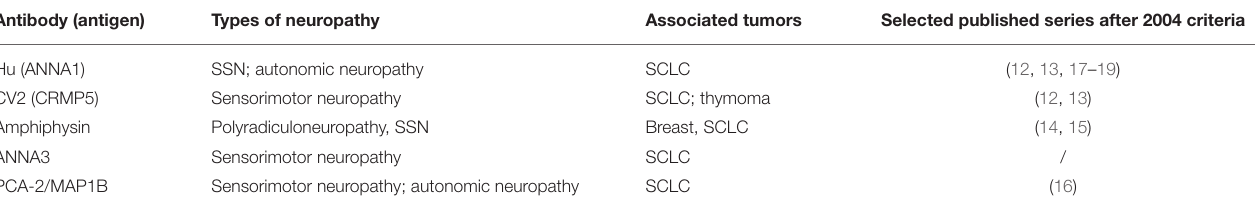
TABLE 2 | Onconeural antibodies reported in 2004 classification and associated with paraneoplastic neuropathy. Antibody